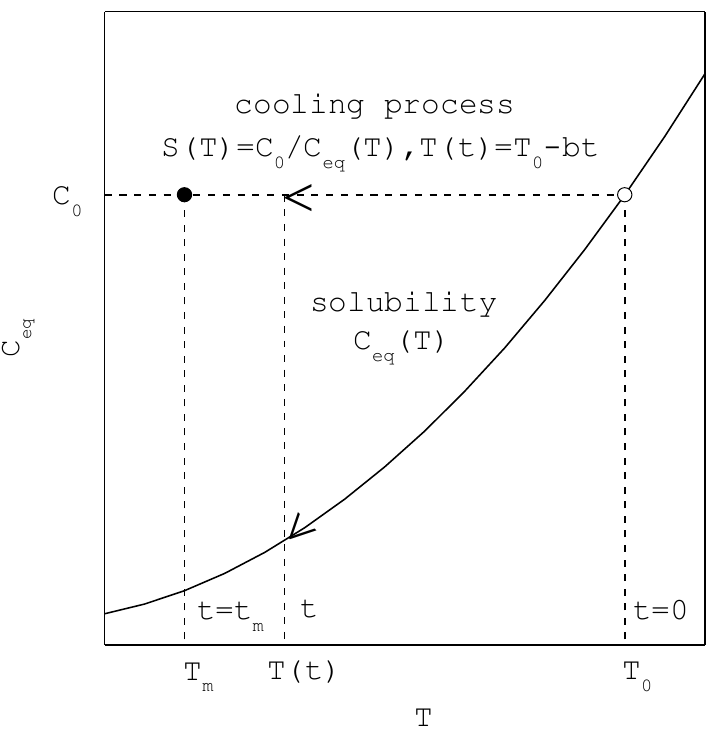
Figure 1. A schematic diagram showing the increasing of supersaturation during the cooling process reproduced from Shiau [31], where 𝐶 𝑒𝑞 (𝑇) is the temperature-dependent solubility ( ○ represents the starting point and ● represents the nucleation point).